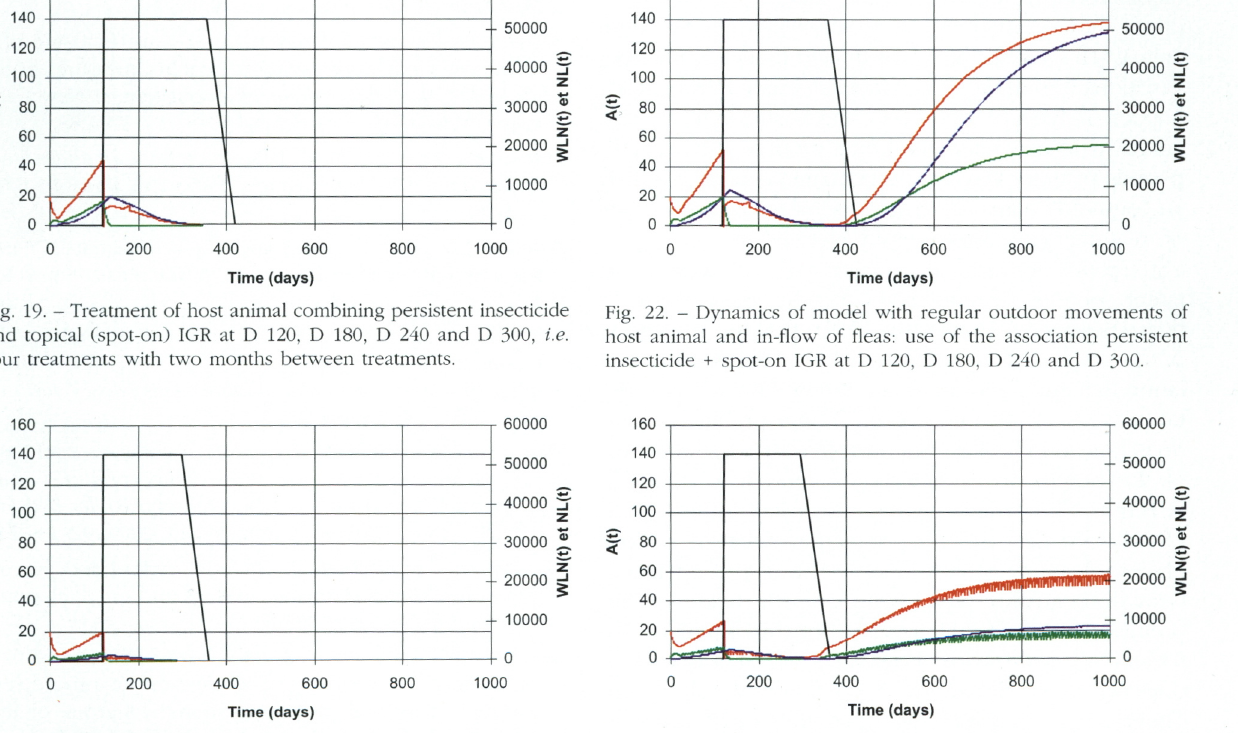
Fig. 23. - Dynamics of model with regular outdoor movements of host animal and in-flow of fleas: use of the association persistent insecticide + spot-on IGR at D 120, D 180, D 240 + regular vacuum cleaning of the home environment premises once a